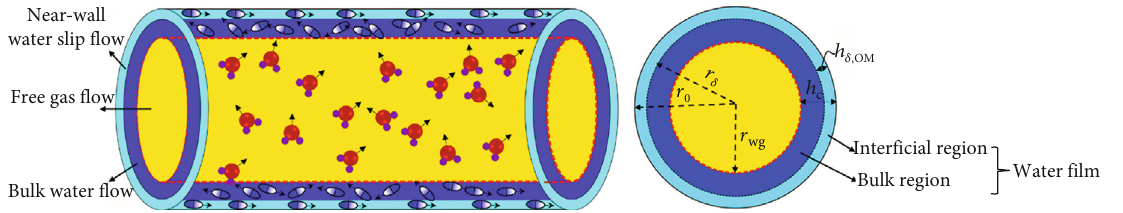
Figure 1: Illustration of the gas-water fl ow in nanoscale organic pores (viscous and slip fl ow of free gas in the pore center, viscous fl ow of bulk water, and the viscous and slip fl ow of near-wall water).